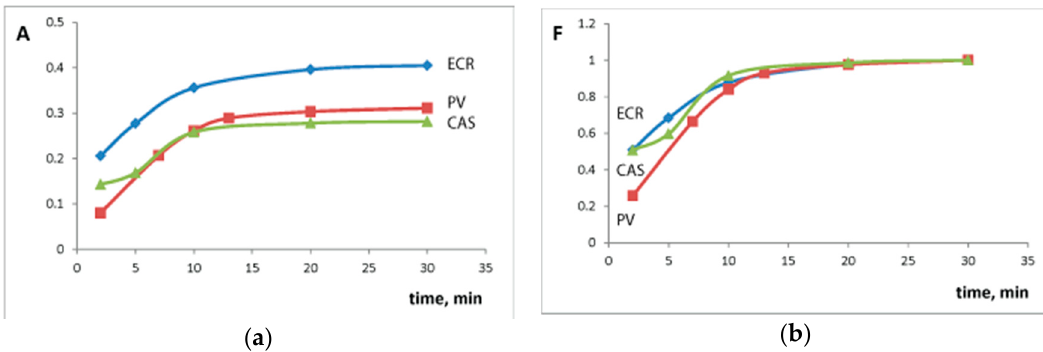
Figure 3. The kinetics of the interaction of silica–titania xerogels with 1 × 10 − 4 M triphenylmethane dyes solution: ( a ) dependence of xerogel absorbance on time; ( b ) dependence of conversion on time. PV—pyrocatechol violet ( λ 640 nm, pH 7.3); ECR—eriochrome cyanine R ( λ 570 nm, pH 2.0); CAS—chrome azurol S ( λ 550 nm, pH 3.0). m/V = 0.10 g/5.0 mL.